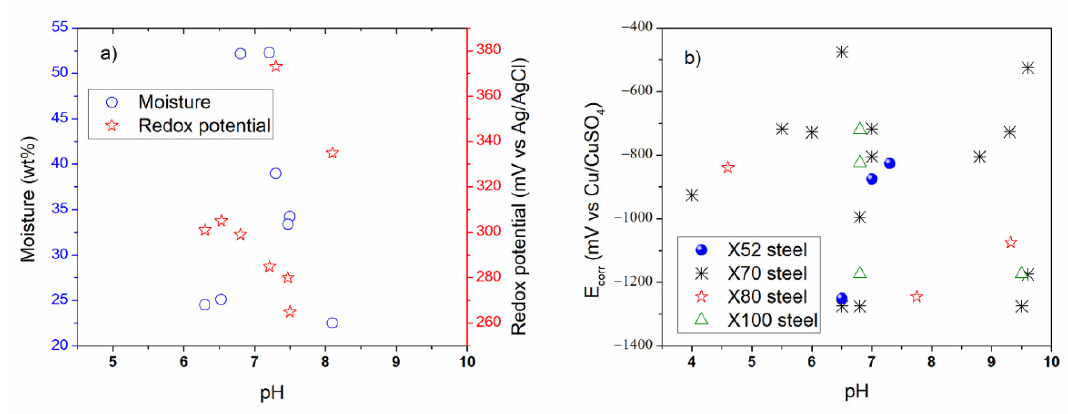
Figure 4. External corrosion analysis based on the reviewed ( a ) physicochemical properties, and ( b ) physicochemical and electrochemical properties.